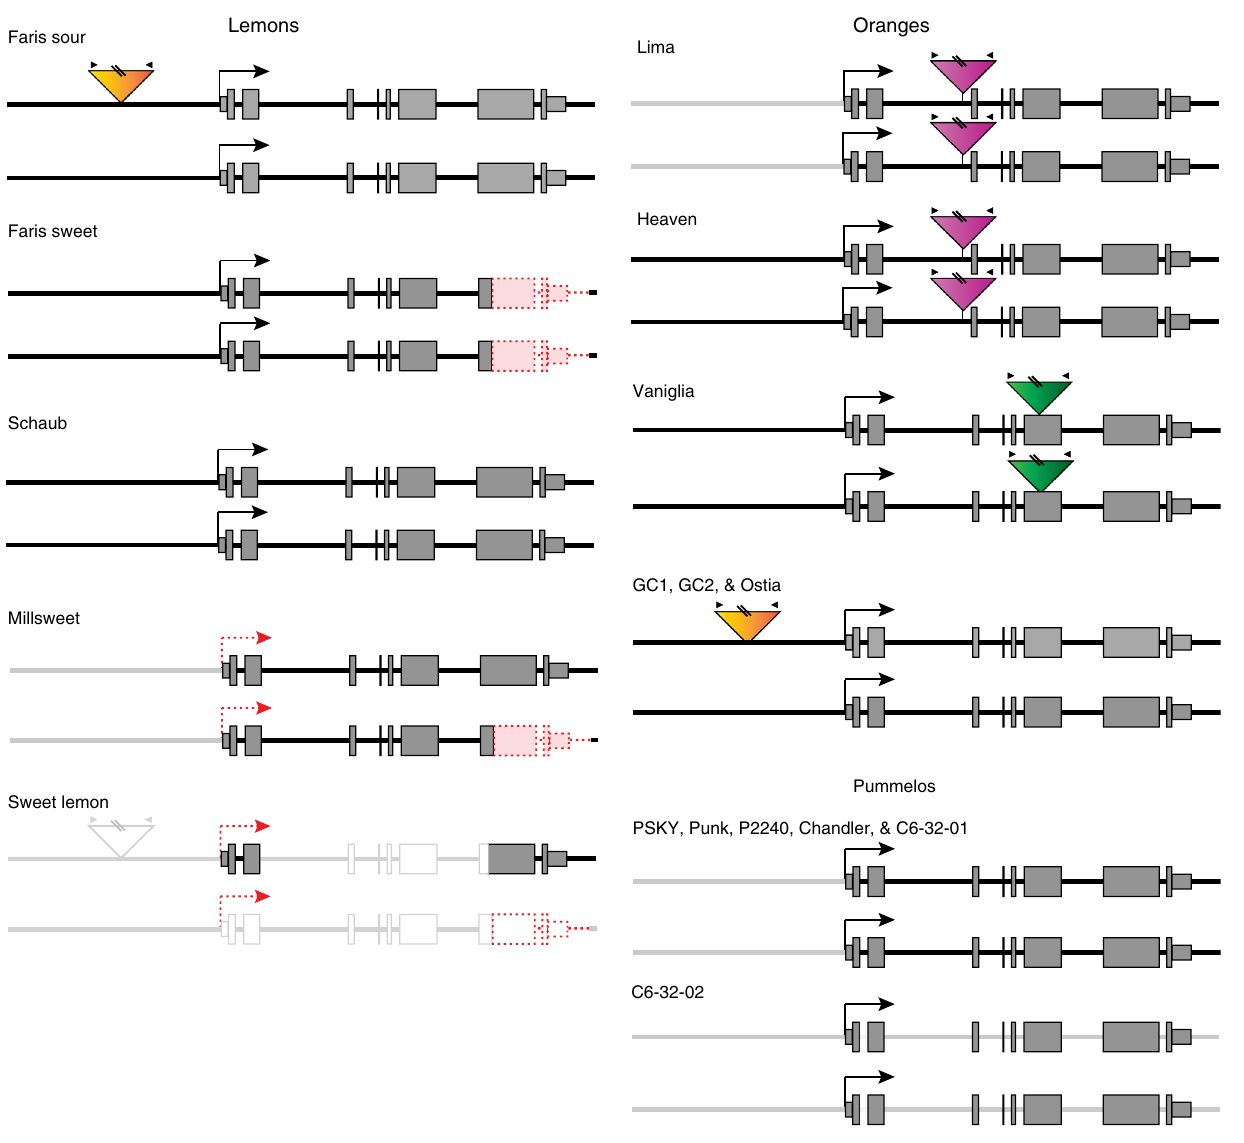
Fig. 4 Structure and expression of CitAN1 alleles in distinct lemon, orange, and pummelo varieties. Exons are indicated by rectangles with 5 ’ and 3 ’ untranslated regions at reduced height. Deleted sequences are indicated with dotted red lines and pink fi lling and transposon insertions by triangles with different colors. The hooked arrow marks the transcription start. The red dotted hooked arrows in ‘ Millsweet ’ and Sweet lemon indicate (inferred) reduced transcription caused by reduced activity of an upstream regulator(s). Gene structures con fi rmed by sequencing are depicted as dark gray lines (introns and fl anking DNA), fi lled rectangles (exons), or fi lled triangles (transposon insertion). Gene structures inferred from polymerase chain reaction alone are marked by gray lines and white fi